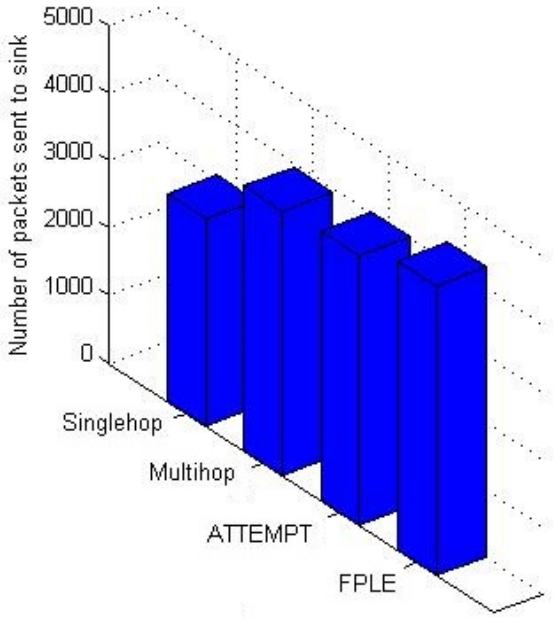
Figure 6. Network Figure 6. Network Throughput.